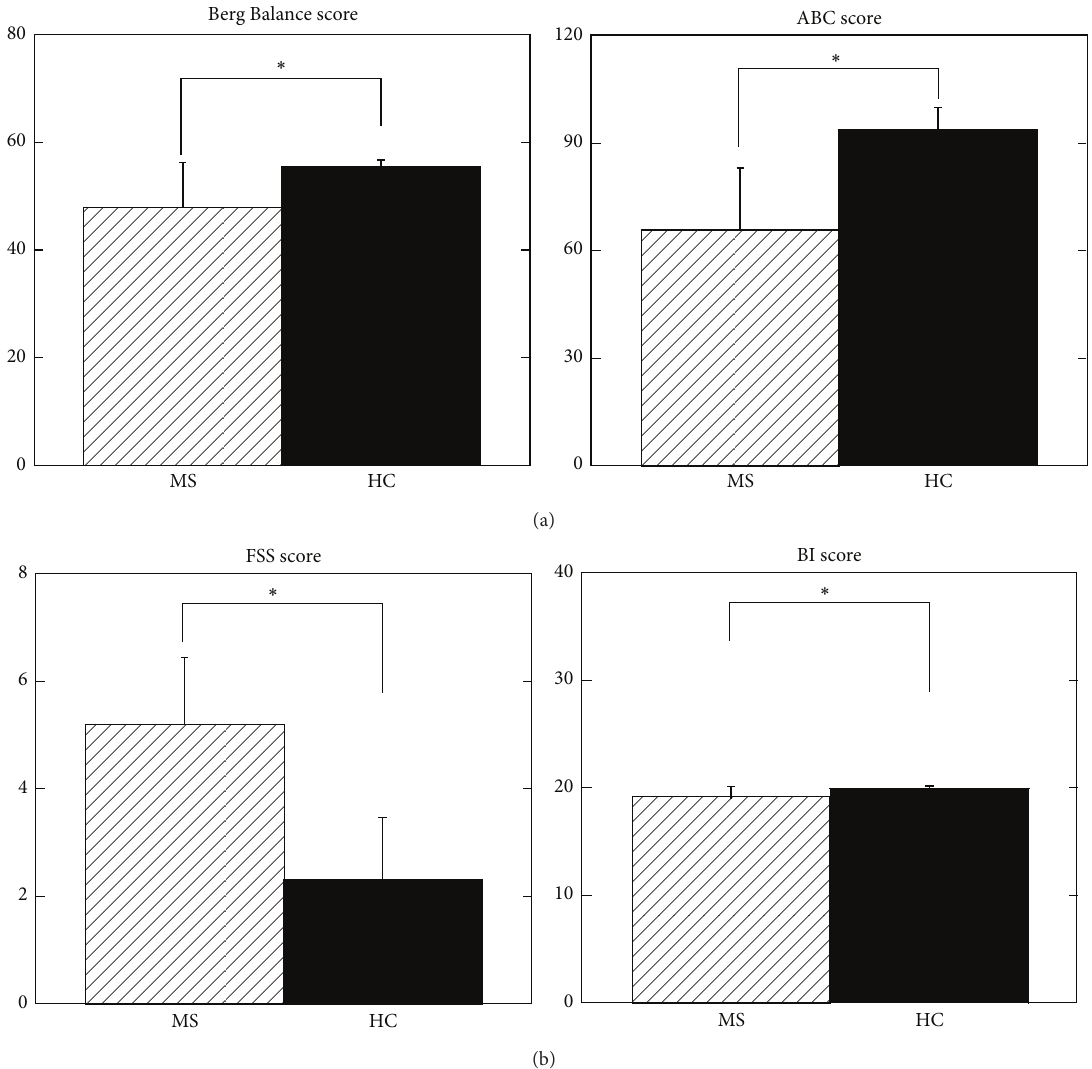
Figure 1: (a) Berg Balance score and Activities-specific Balance Confidence (ABC) scores for the group of individuals with multiple sclerosis (MS) and healthy control (HC) subjects. (b) Fatigue Severity Scale (FSS) and Barthel Index (BI) scores are shown for the MS and healthy control groups. ∗ denotes statistically significant differences at 𝑃 < 0.05